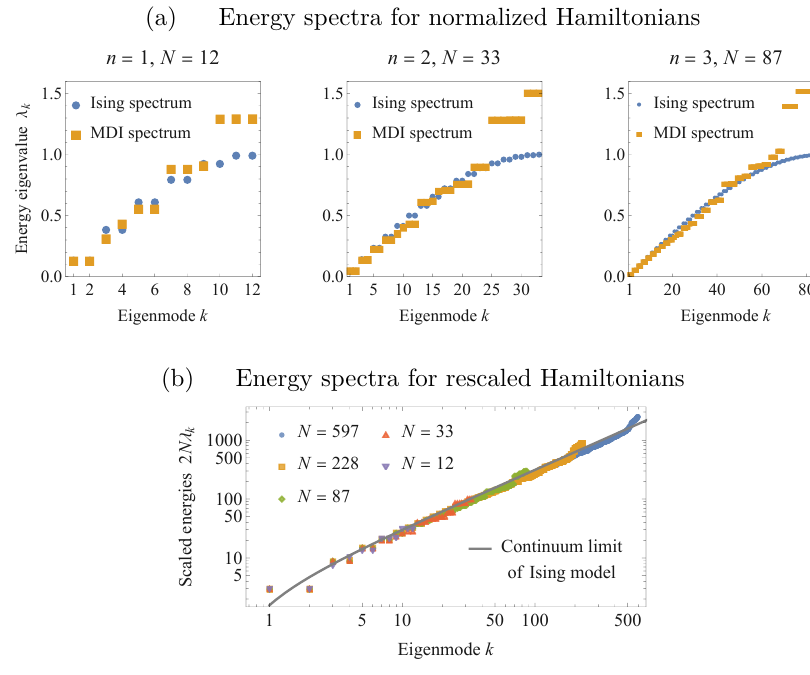
Figure 11 . (a) Spectrum of the critical Ising Hamiltonian (2.11) vs. the mode-disordered Ising (MDI) Hamiltonian (3.5) for the { 3 , 7 } MTN at the critical Ising point, the latter with normalized P disorder 1 g k = 1 , at three successive inflation steps on N = 12 , 33 , and 87 sites ( n = 1 , 2 , 3 k 2 N inflation steps, respectively). (b) Overlaid spectrum of MDI Hamiltonian for various N with rescaled energies 2 Nλ k , along with the dispersion relation of the continuum Ising model. The MDI spectra overlap up to finite N effects, indicating an RG flow between inflation